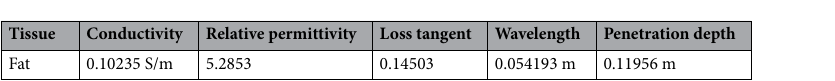
Table 3. Fats parameters in the resonance frequency.